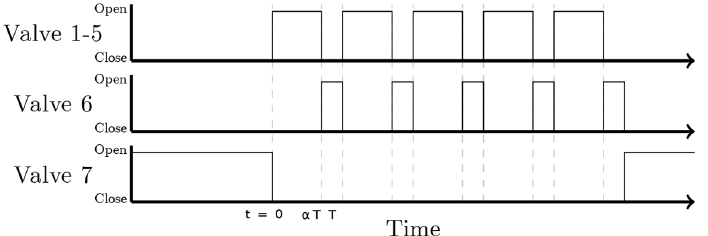
Fig 3. Chronogram of the activation of valves. During the rest period, valve 7 delivers clean air. During the stimulation period, the odor pulse is delivered through valve 1 – 5 every T period and the flow is compensated with valve 6.